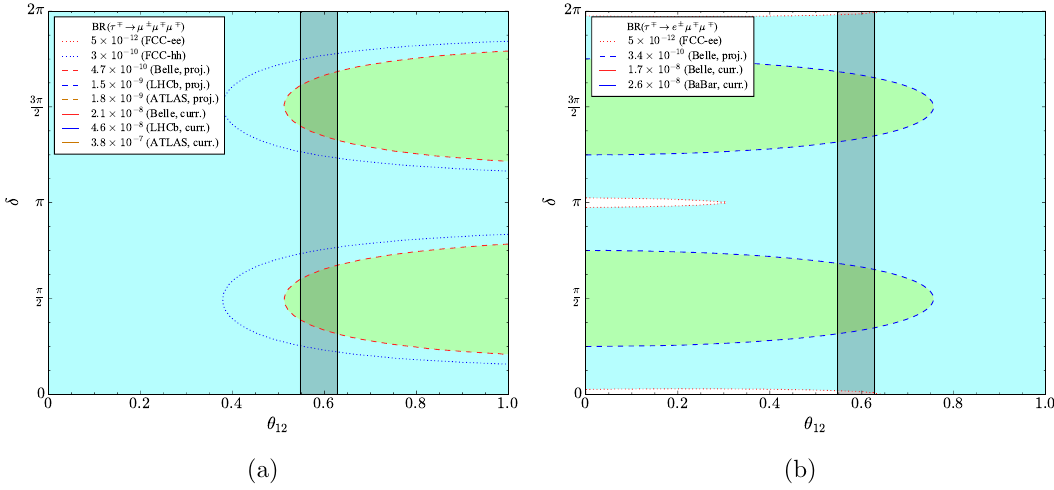
Figure 3. Current and future branching ratio limits in the parameter plane of the